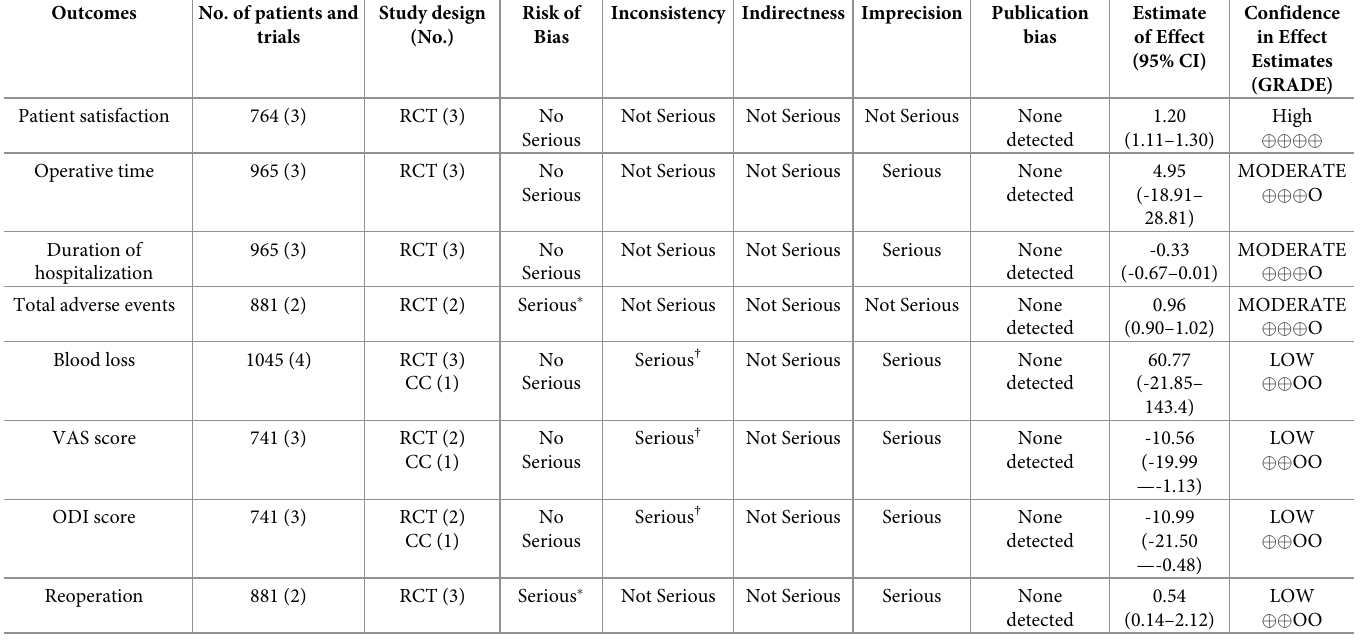
Table 3. Quality of evidence for outcome based on GREAD